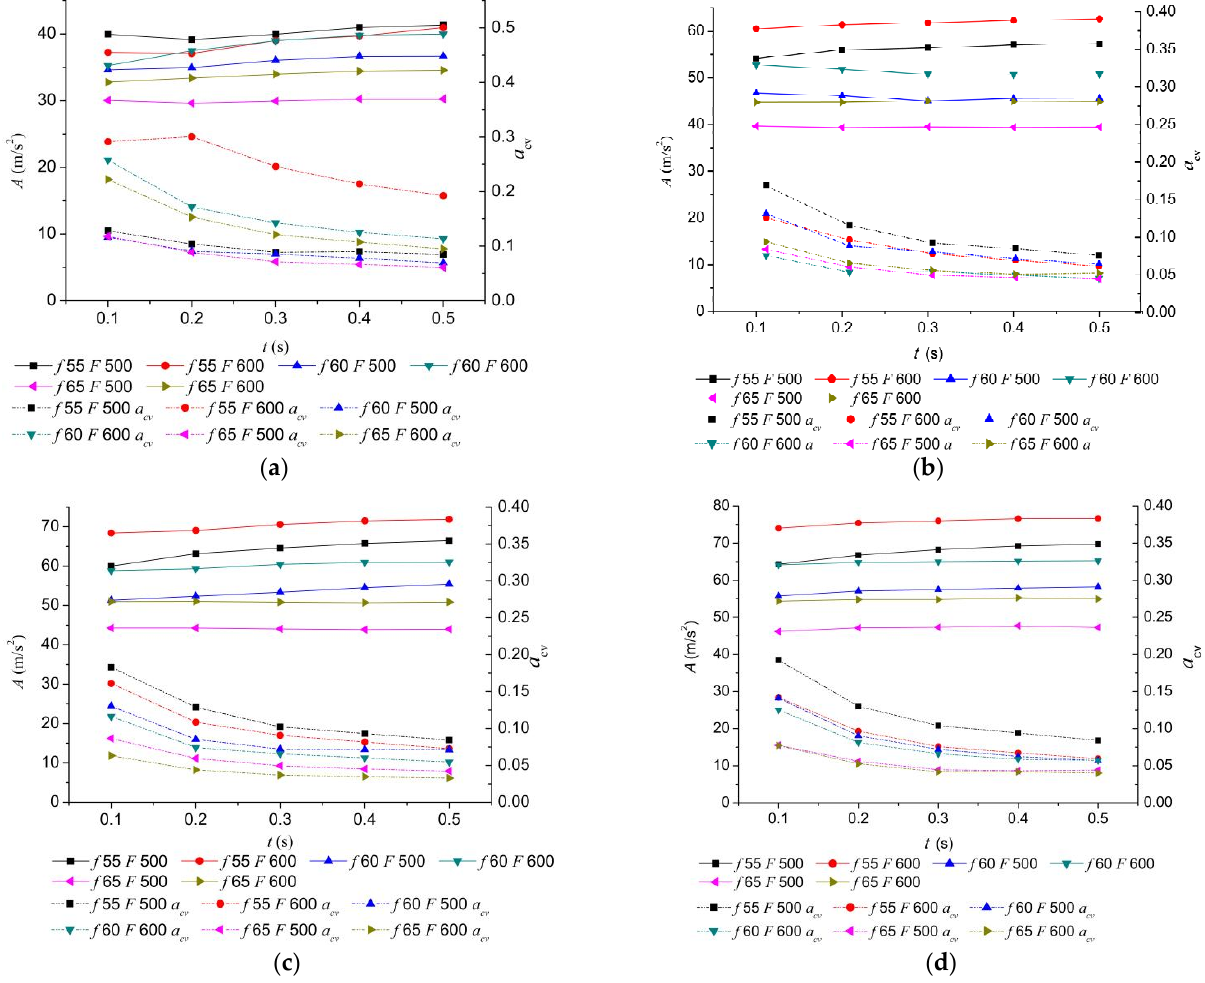
Figure 6. Curves of A and a cv changing with the statistical time length. ( a ) E = 500, ( b ) E = 1300, ( c ) E = 2100, ( d ) E = 2900.